Question: In a single sentence, describe what this figure presents.
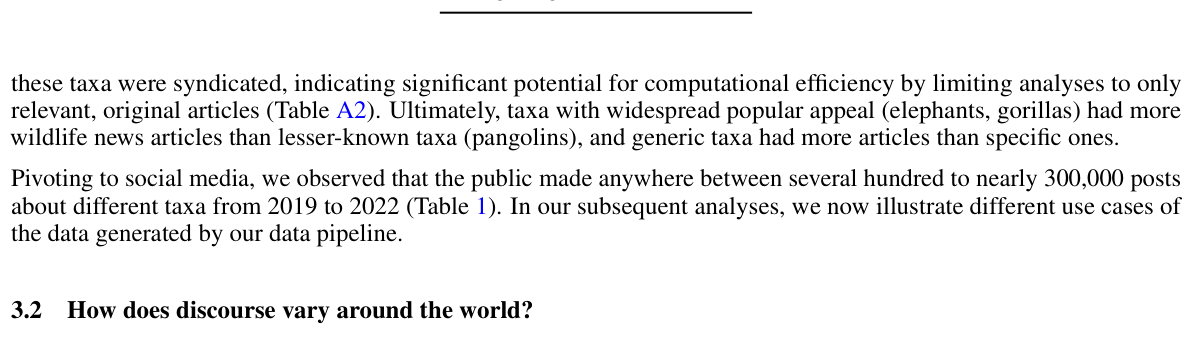
Answer: shows spatial variations in media coverage across different taxa. Globally recognized animals like gorillas receive widespread attention online, while less well-known taxa such as pangolins and pipistrelle bats see more geographically concentrated coverage. Pangolins are primarily featured in Southeast Asia, whereas pipistrelle bats, despite their prevalence in the British Isles and widespread distribution in Asia, attract less media attention outside the